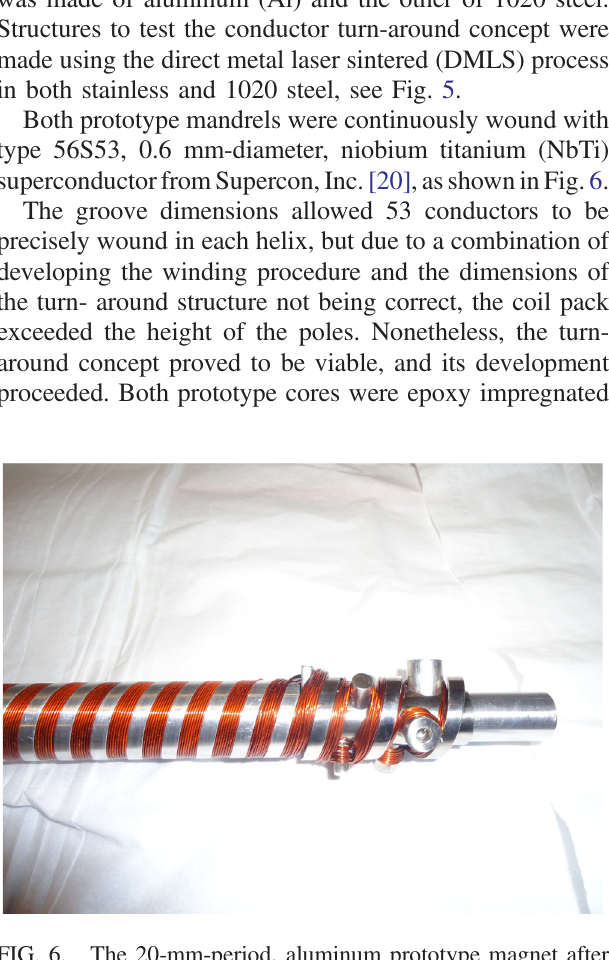
FIG. 6. The 20-mm-period, aluminum prototype magnet after